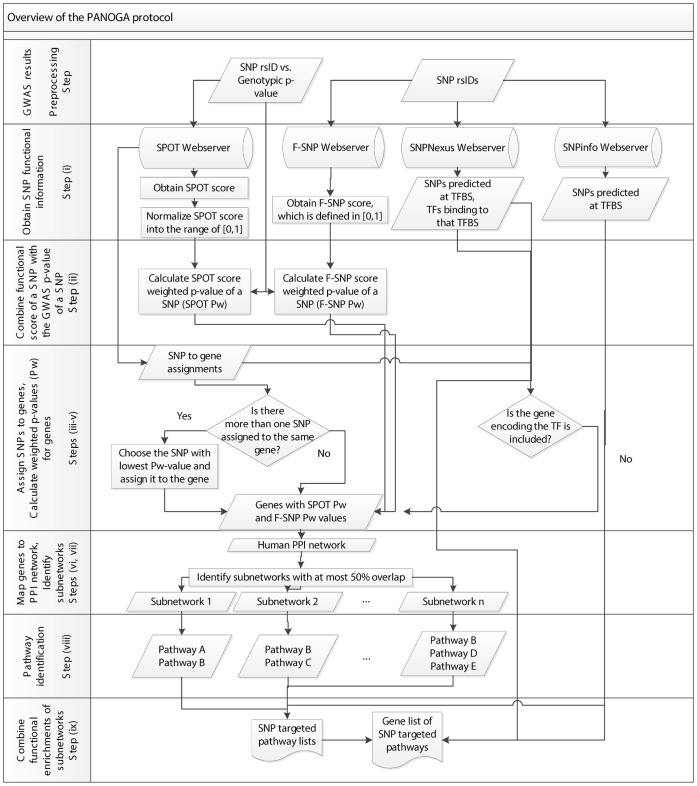
Outline of our assessment process.In steps (i) to (v), a gene-wise Pw-value for association with disease was computed by integrating functional information. In step (vi), Pw-values were loaded as two separate attributes of the genes in a PPI network. In step (vii), active sub-networks of interacting gene products that were also associated with the disease, are identified. In step (viii), genes in an identified active sub-network were tested whether they are part of functionally important KEGG pathways. Lastly, step (ix) integrates the functional enrichments of the generated sub-networks.